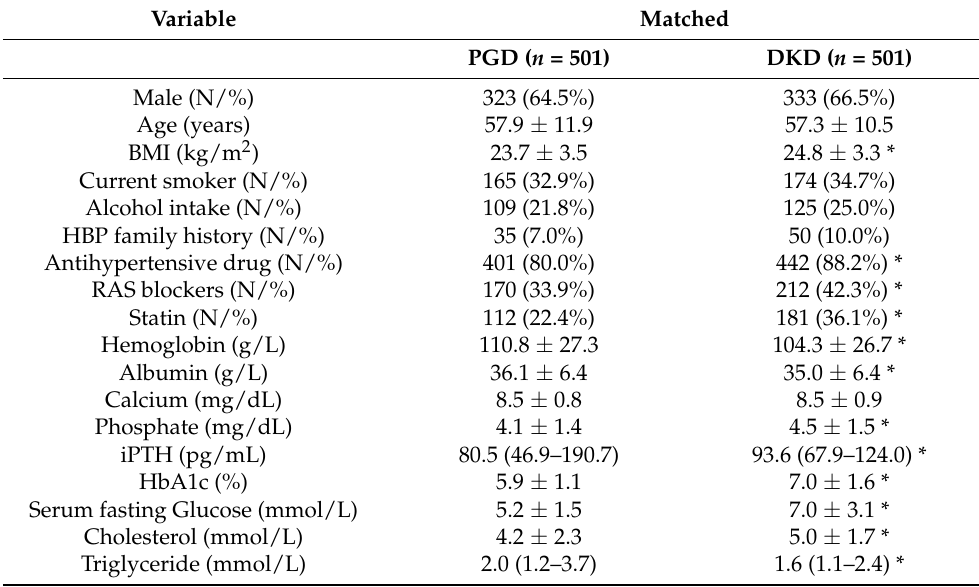
Table 1. Demographic and clinical characteristics of type 2 DKD patients ( n = 501) and PGD patients ( n =